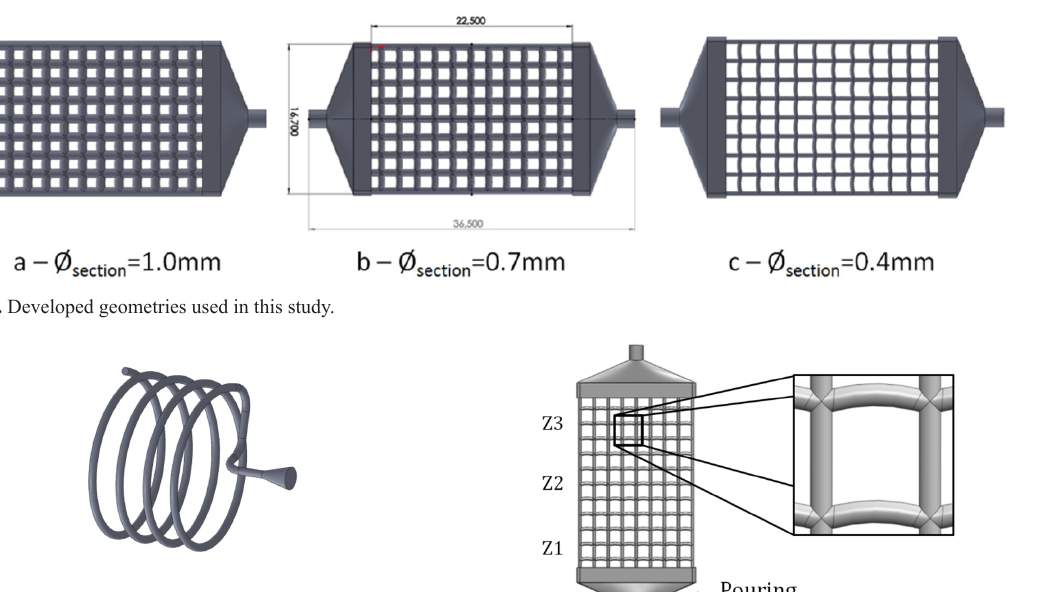
=0.5mm). section Figure 5. Detail of metallurgical analysis zones in sample according to the distance from pouring